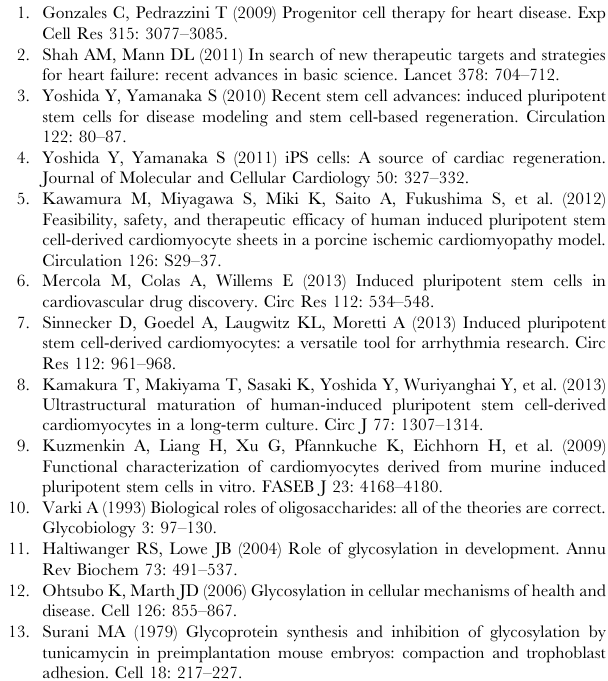
Table S1 Structures and relative quantities of neutral (Table S1, S2) PA-oligosaccharides derived from iPSC, iPSC-CM, and heart cells. a. Glucose units (GU) were calculated from the peak elution times of the peaks obtained from the ODS column in Figure 5, 6, 7 and the Amide column (data not shown). b. Average mass calculated from the mlz values of [M + Na] + or [M + H] + ion for neutral, [M-H] 2 ion for mono-sialyl, and [M-H] 2 & [M + Na-2H] 2 ions for di-sialyl PA-oligosaccharides. c. PA-oligosaccharide structures. d. mol% was calculated from the peak area versus total N -glycan content in each cell (TIFF)